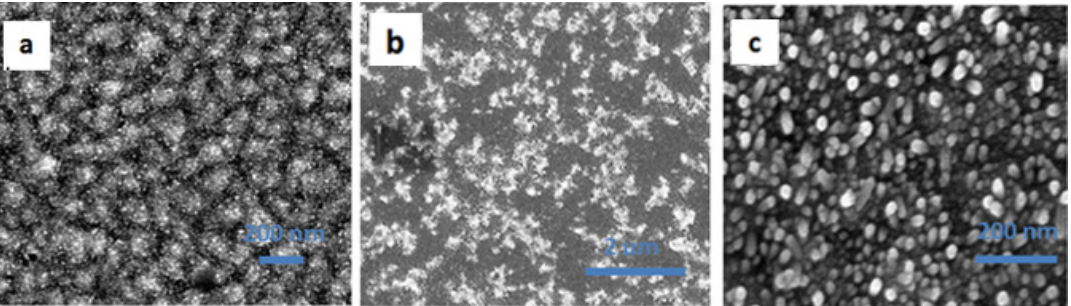
Figure 1. Top view SEM images of ZnAc seed layer at ( a ) 0 min; ( b ) 5 min; ( c ) 10 min. Scale bar is 200 nm for images A and C, and 2 μ m for image B.